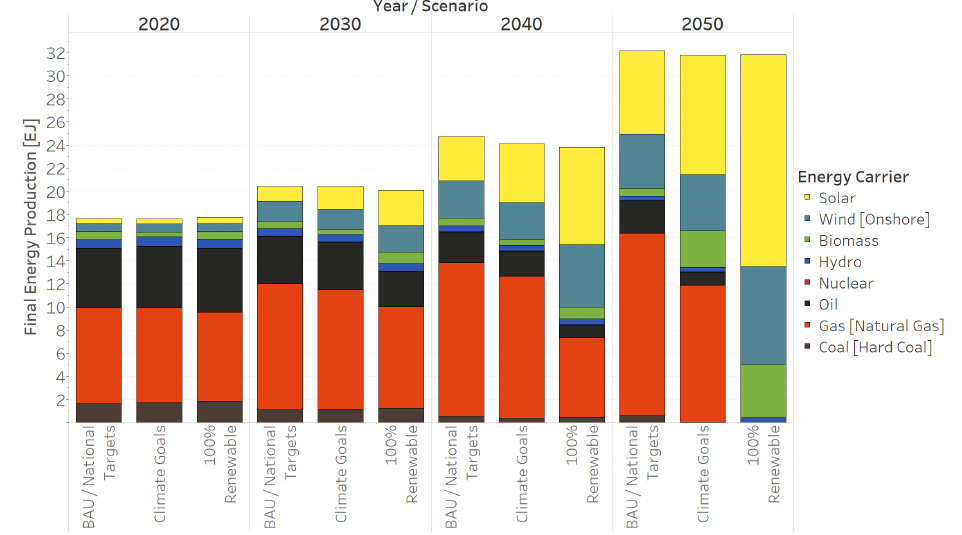
Figure 9. Final energy mix across all sectors per scenario in Exajoule